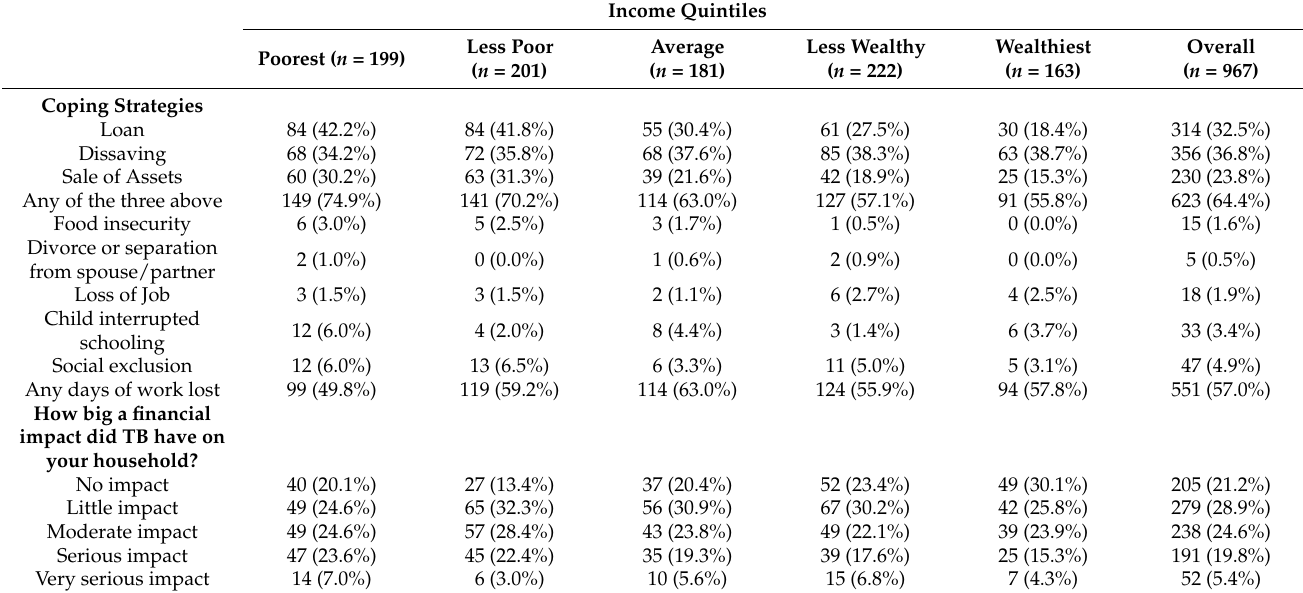
Table 4. Coping mechanisms and social